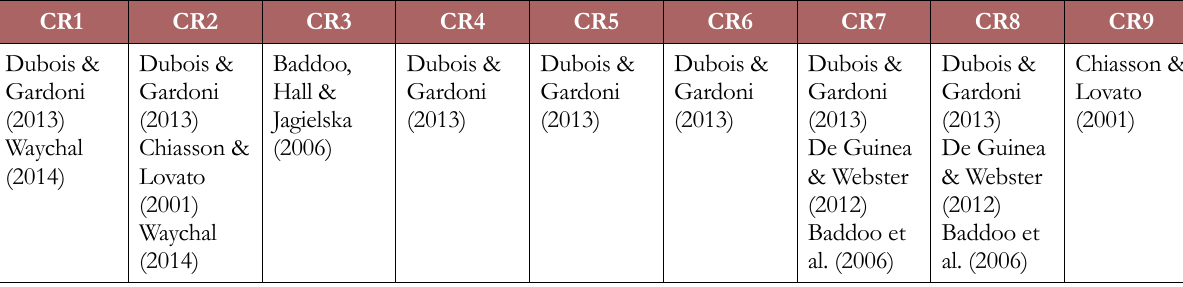
Table 2. FINCODA Creativity and supporting